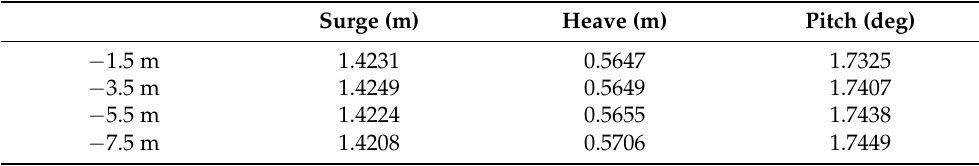
Table 15. Motion RMS with different auxiliary rope fairlead positions under storm self-survival